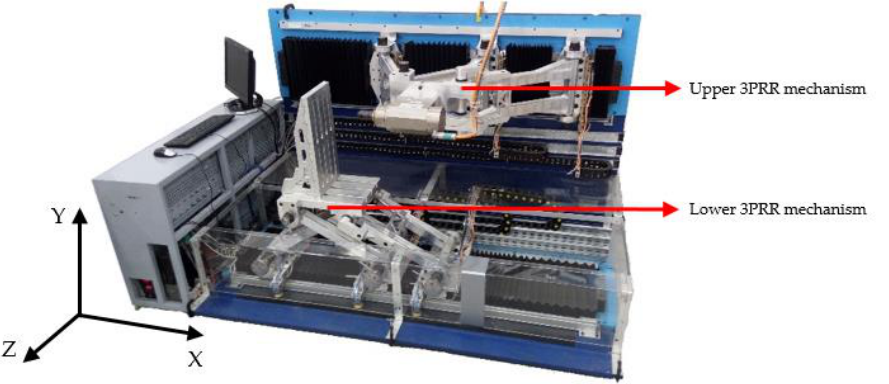
Figure 6. Hybrid-kinematics machine composed of lower and upper 3PRR mechanisms.